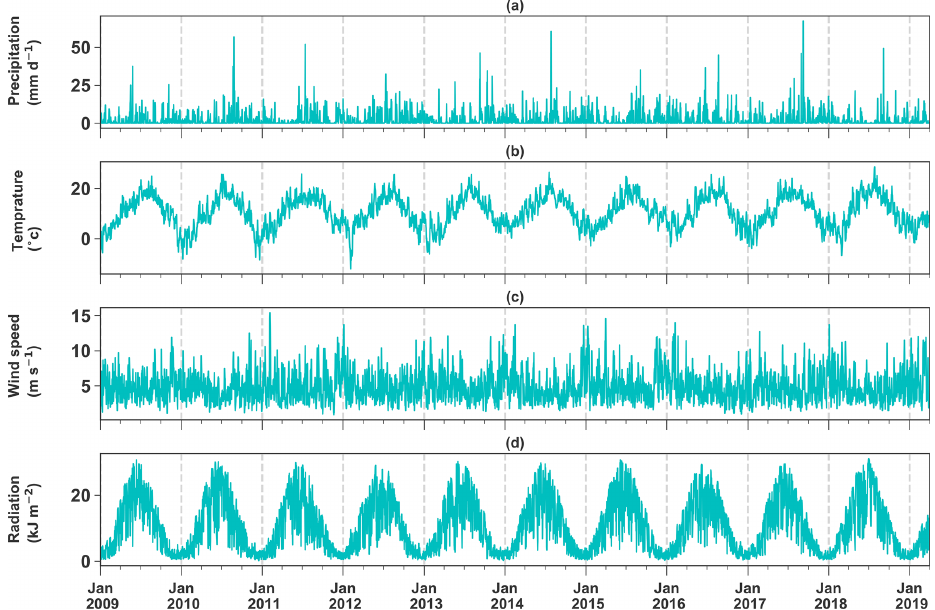
Figure 2. Daily values of inputs for the crop model from 2009 to 2019. (a) Precipitation; (b) radiation; (c) average temperature; (d) average wind speed.